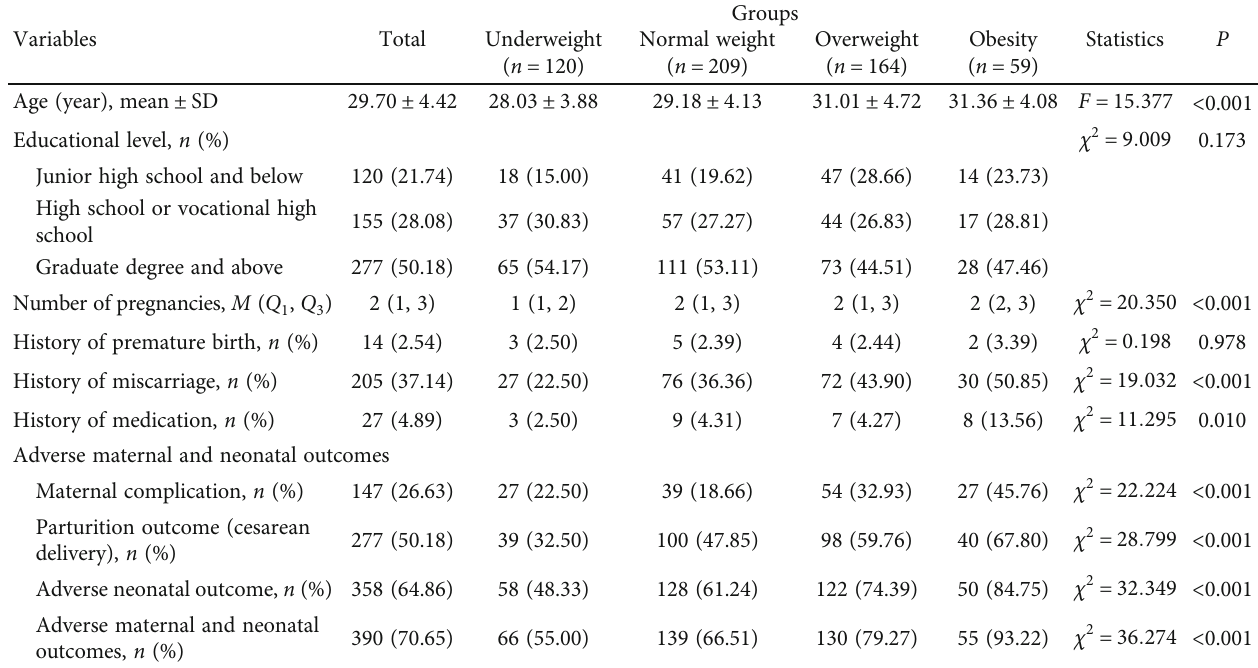
Table 2: Comparison of related characteristics of maternal BMI